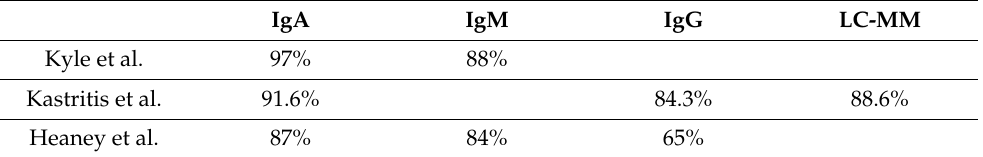
Table 1. Incidence of Immunoparesis by Multiple Myeloma